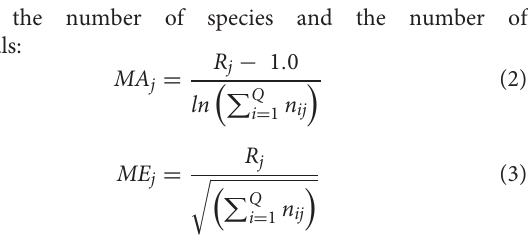
Number of sampled